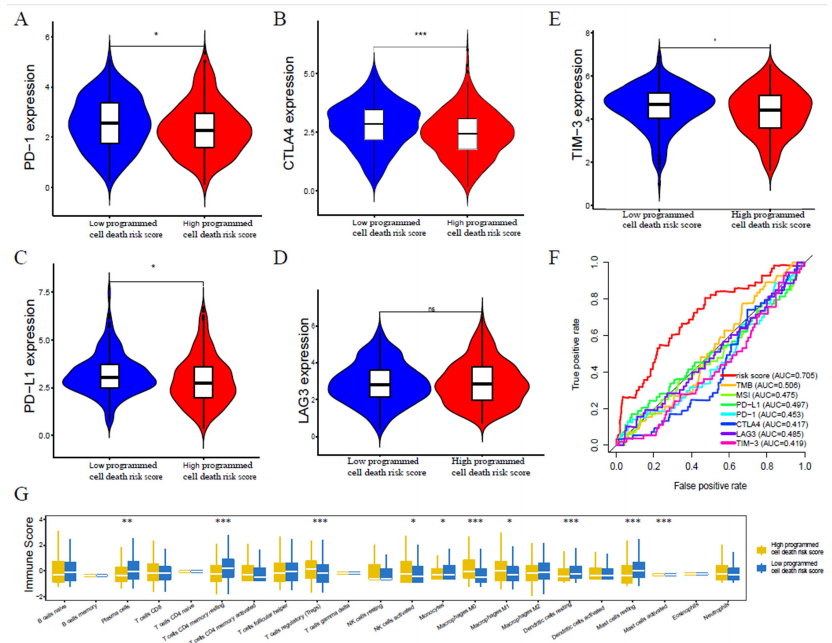
Figure 8. Programmed cell death risk score as the predictor for immunotherapy. ( A ) PD-1 expression difference between high and low programmed cell death risk score patients. ( B ) CTLA4 expression difference between high and low programmed cell death risk score patients. ( C ) PD-L1 expression difference between high and low programmed cell death risk score patients. ( D ) LAG3 expression difference between high and low programmed cell death risk score patients. ( E ) TIM3 expression difference between high and low programmed cell death risk score patients. ( F ) Multivariate ROC of programmed cell death risk score, PD-1, PD-L1, CTLA4, LAG3, TIM3, TMB and MSI. ( G ) Immune cells infiltration difference between high and low Programmed cell death risk score patients. ∗ p < 0.05, ∗∗ p < 0.01, ∗∗∗ p <